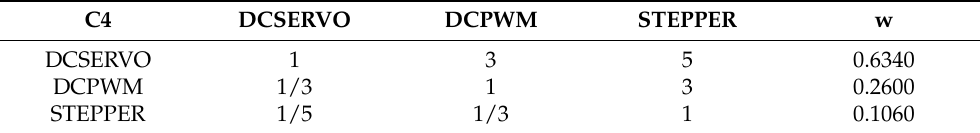
Table 7. Pairwise comparison of the actuation solutions (criterion